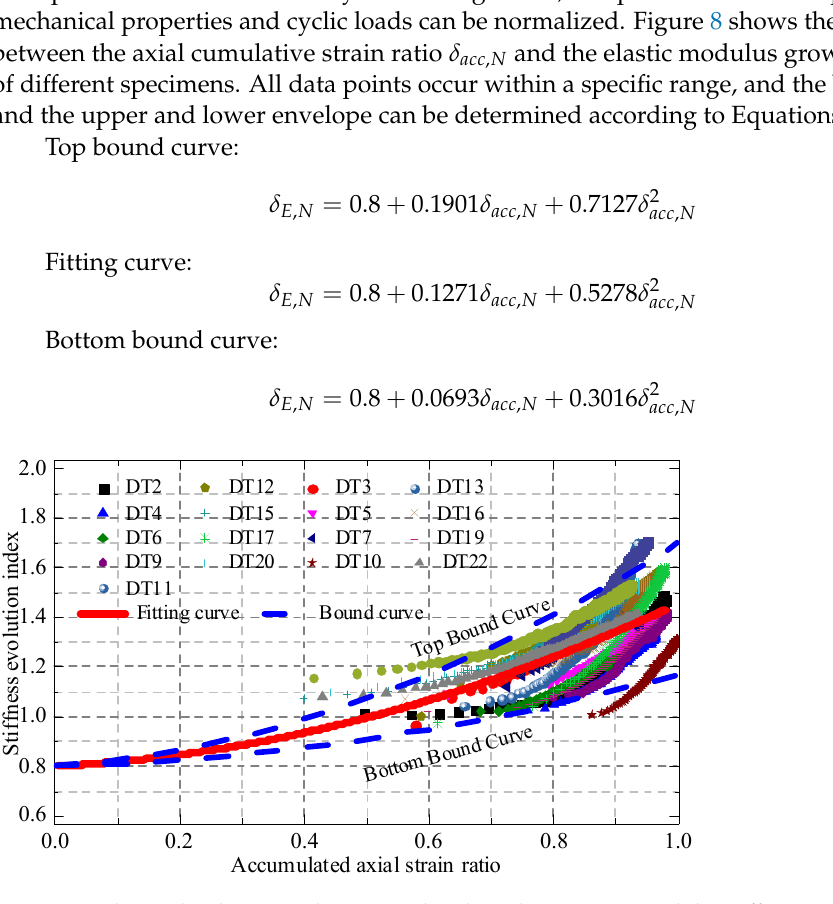
Figure 8. Relationship between the accumulated axial strain ratio and the stiffness evolution in- dex.